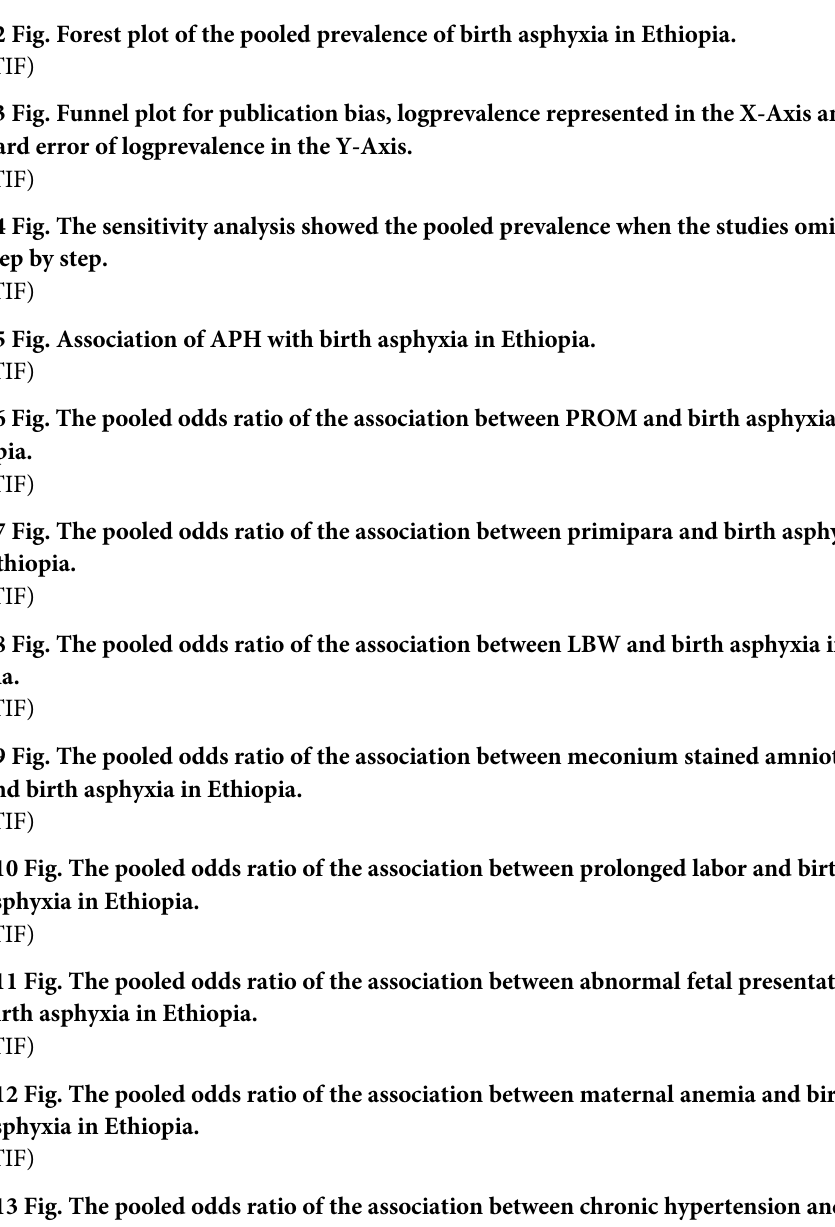
S1 Fig. Diagram of information flow through phases of systematic review. (TIF) S2 Fig. Forest plot of the pooled prevalence of birth asphyxia in Ethiopia. (TIF) S3 Fig. Funnel plot for publication bias, logprevalence represented in the X-Axis and stan- dard error of logprevalence in the Y-Axis. (TIF) S4 Fig. The sensitivity analysis showed the pooled prevalence when the studies omitted step by step. (TIF) S5 Fig. Association of APH with birth asphyxia in Ethiopia. (TIF) S6 Fig. The pooled odds ratio of the association between PROM and birth asphyxia in Ethi- opia. (TIF) S7 Fig. The pooled odds ratio of the association between primipara and birth asphyxia in Ethiopia. (TIF) S8 Fig. The pooled odds ratio of the association between LBW and birth asphyxia in Ethio- pia. (TIF) S9 Fig. The pooled odds ratio of the association between meconium stained amniotic fluid and birth asphyxia in Ethiopia. (TIF) S10 Fig. The pooled odds ratio of the association between prolonged labor and birth asphyxia in Ethiopia. (TIF) S11 Fig. The pooled odds ratio of the association between abnormal fetal presentation and birth asphyxia in Ethiopia. (TIF) S12 Fig. The pooled odds ratio of the association between maternal anemia and birth asphyxia in Ethiopia. (TIF) S13 Fig. The pooled odds ratio of the association between chronic hypertension and birth asphyxia in Ethiopia.